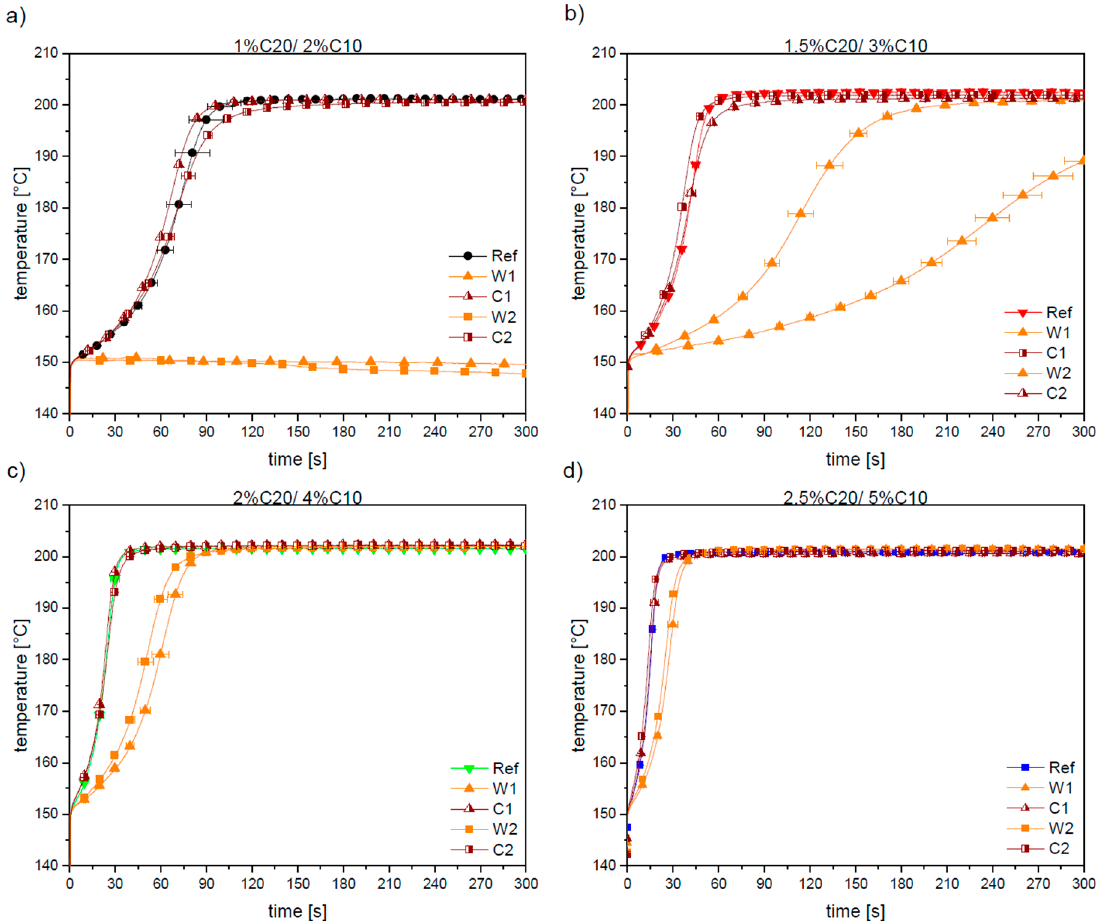
Figure 12. Compensation series of F1 ( a ), F2 ( b ), F3 ( c ) and F4 ( d ). Polymerized at T pol = 150 °C and T mold = 150 °C.